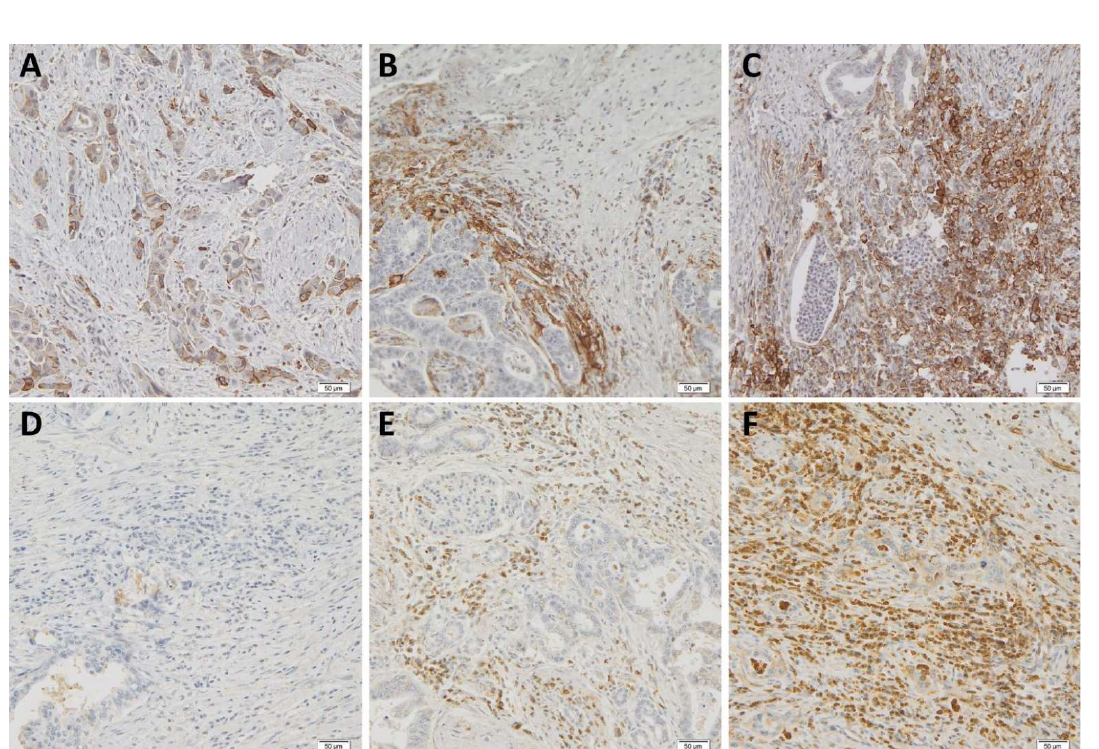
Figure 1. Representative examples of immunohistochemical stainings. ( A ) Intense, membranous PD-L1 reaction in pancreatic carcinoma cells with prominent budding; ( B ) high expression of PD- L1 restricted to TAICs and lack of reaction in TCs; ( C ) PD-L1 staining visible mainly in TAICs and in some TCs; ( D ) negative VISTA staining reaction in both TAICs and TCs; and ( E , F ) high expression of VISTA in the majority of TAICs and lack of reaction in TCs.